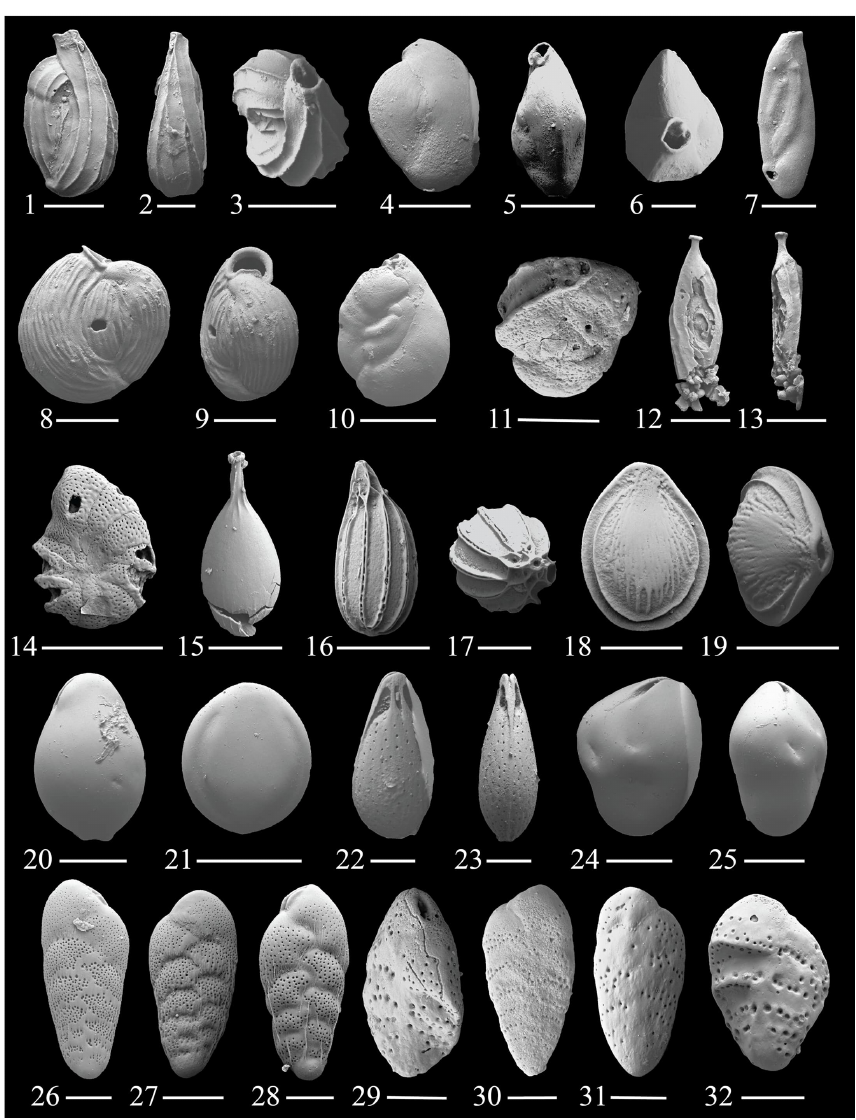
Figure 5. (1–3) Quinqueloculina cf. Q. carinatastriata Wiesner; (4–6) Quinqueloculina sp. 3; (7) Quinqueloculina cf. Q. bosciana d’Orbigny; (8–9) Miliolinella webbiana d’Orbingy; (10) Miliolinella sp. 1; (11) Hauerina atlantica Cushman; (12–13) Inaequalina sp. 1; (14) Laevipeneroplis bradyi Cushman; (15) Procerolagena oceanica (Albani); (16–17) Cushmanina bricei McCulloch; (18–19) Fissurina colomboensis McCulloch; (20) Fissurina bispinata Ujiié; (21) Fissurina sp. 2; (22–23) Fissurina semimarginata Reuss; (24–25) Fissurina